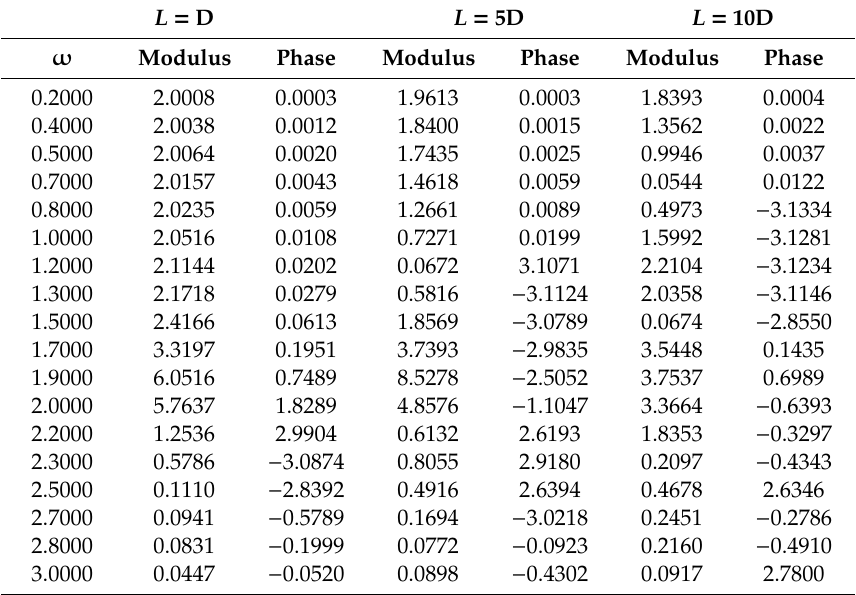
Table A1. Heave responses (modulus and phase) of the 1st WEC device for the C1 arrangement. L = D L = 5D